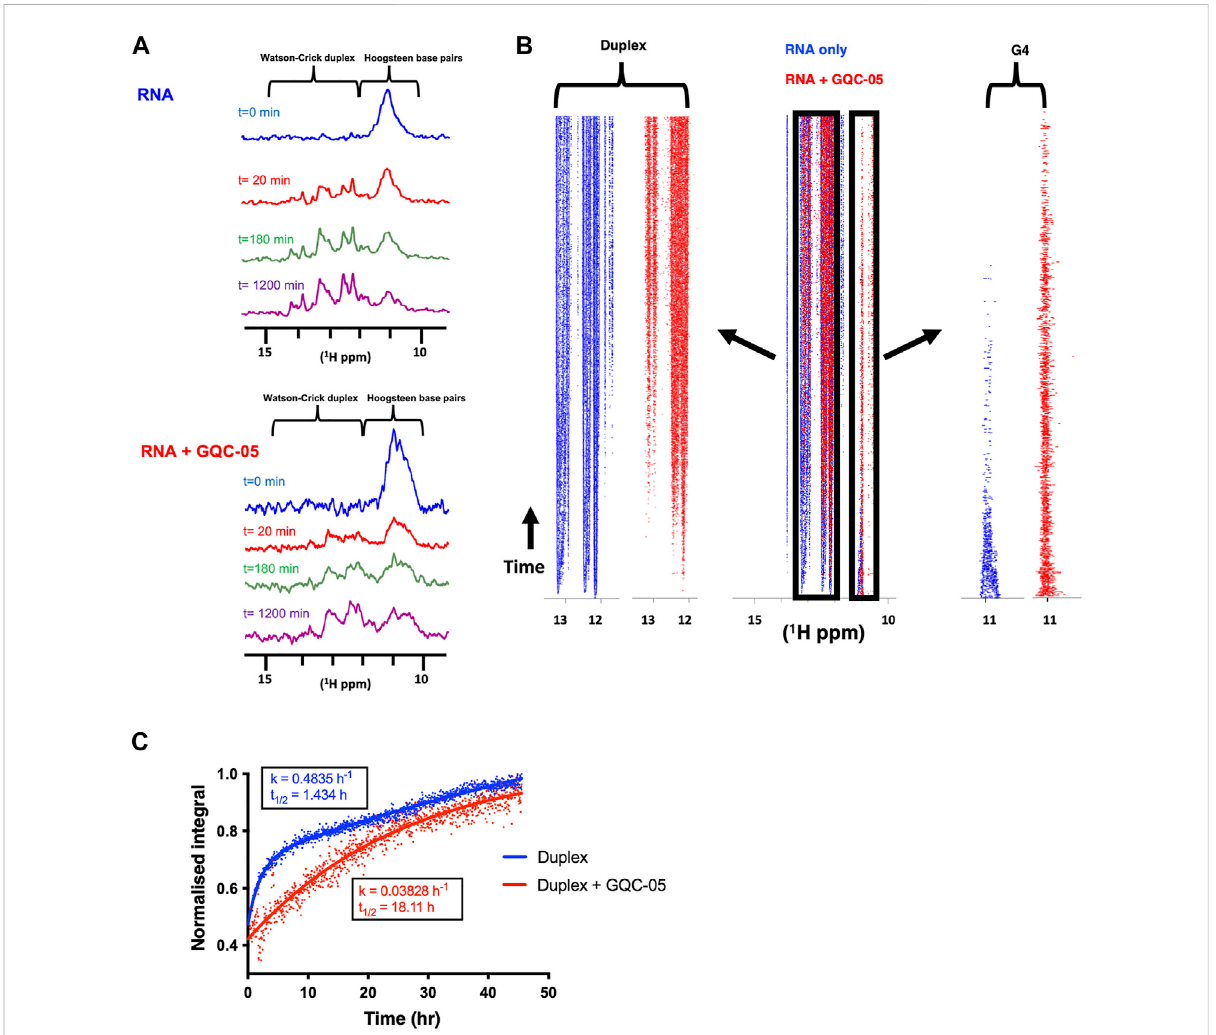
FIGURE 10 GQC-05 stabilises a G4 over duplex formation of the Q2 163 – 192 RNA (A) 1 H NMR spectrum at various time points after the addition of a complementary strand in the absence (top) and presence (bottom) of 4 equivalents of GQC-05 (B) Pseudo-2D traces displaying the peak intensities across the imino region as a function of time in the absence (blue) and presence (red) of GQC-05. Zoomed in on the left and right panels are the peaks corresponding to the duplex and G4 regions respectively. (C) Normalised peak integrals in the duplex region as a function of time